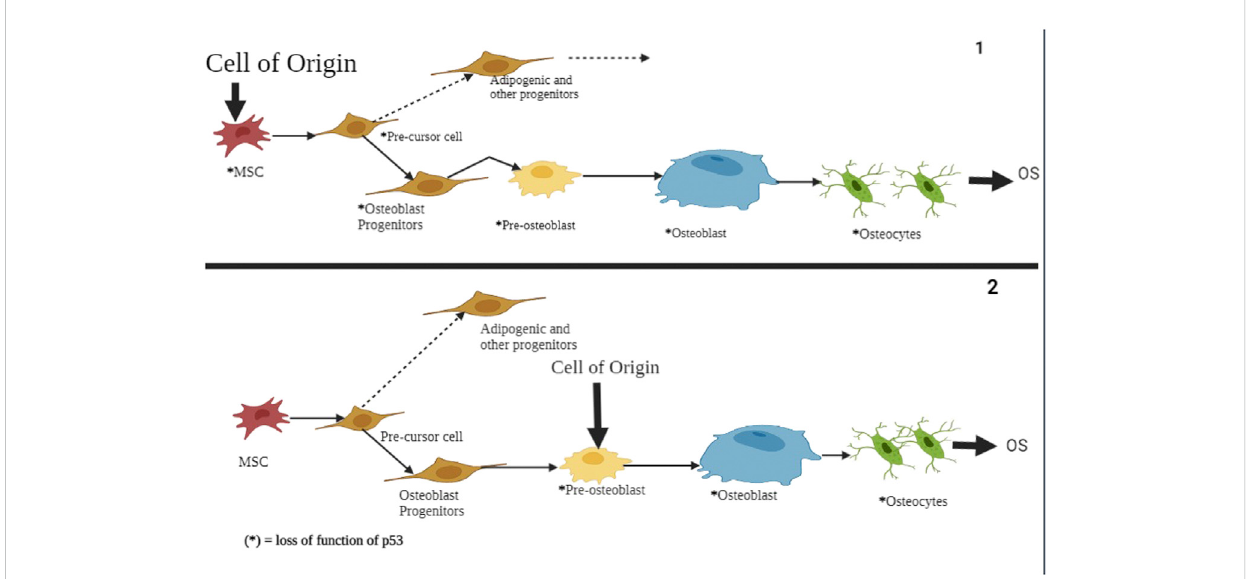
FIGURE 9 A schematic representation of p53 ’ s role in atypical and typical ferroptosis in osteosarcoma. In both cases, the functional loss of p53 is the origin of osteosarcoma and undifferentiated MSCs. The regulatory mechanisms affect osteoblasts, pre-osteoblasts, and undifferentiated MSCs. Mutation of the p53 tumor suppressor genes results in aberration of pre-osteoblast cells and mesenchymal progenitor cells, subsequently showing proliferation and compromised growth alongside terminal